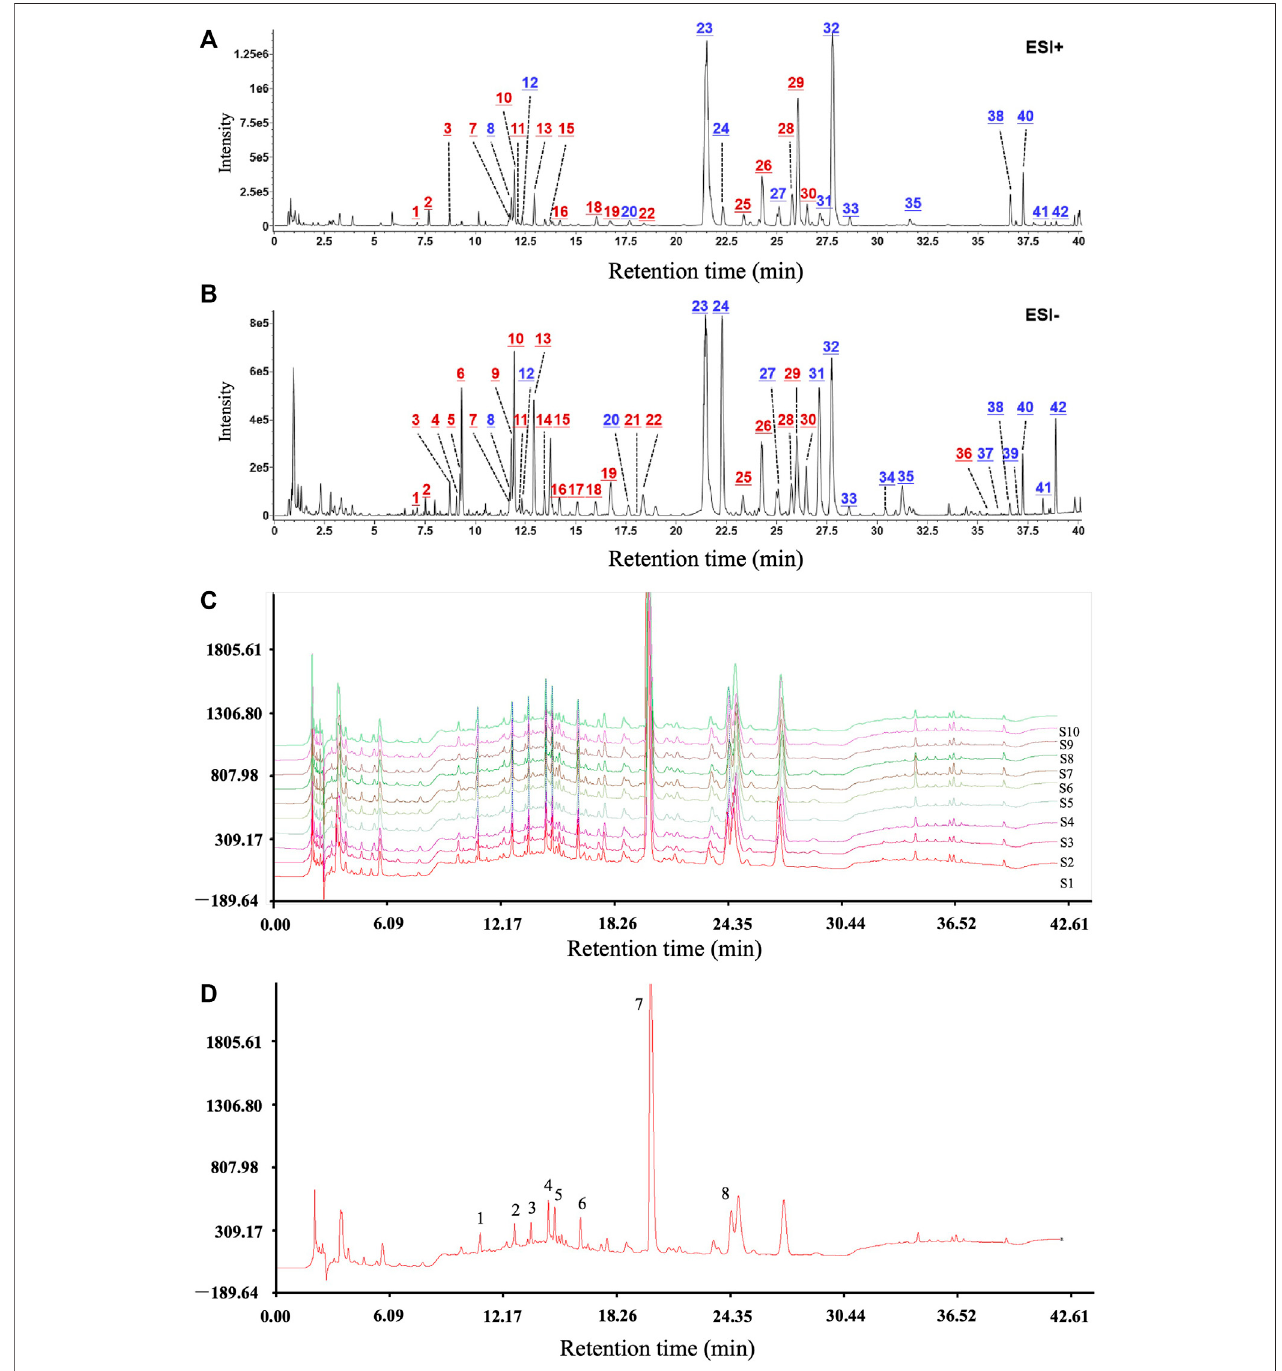
FIGURE1| ThemainactivecomponentsandgoodreproducibilityoftheWBTformulaweredeterminedbyUHPLC/Q-TOF-MSanalysis. (A,B) Thechromatograms of the WBT formula for 42 active components in positive and negative ion modes. Blue numbers represent the compounds con fi rmed with the reference standards. (C and D) ThereproducibleHPLC fi ngerprintsofthe10batchesofWBT(S1 – S10)wereidenti fi edusingtheSimilarityEvaluation SystemforChromatographicFingerprintof Traditional Chinese Medicine (2004 Edition).